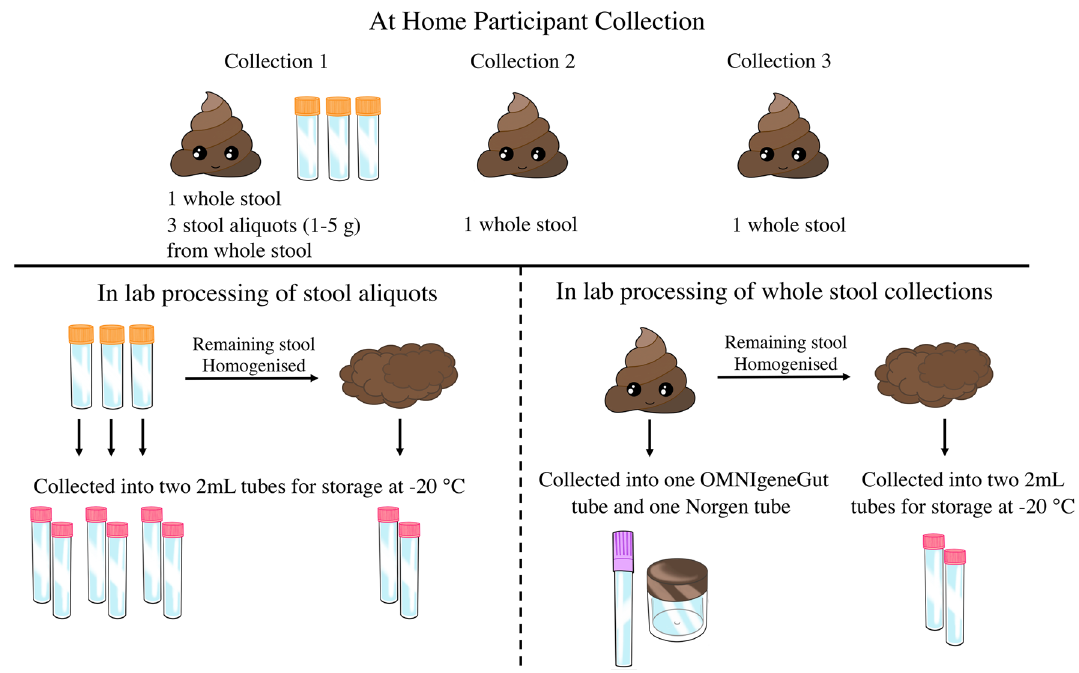
Figure 7. Sample collection by participants at home (top panel), and subsequent sample processing in laboratory (bottom panel). The first bowel movement of the day was obtained for collection 1 and 2, and the very next bowel movement after collection 2 was obtained for collection